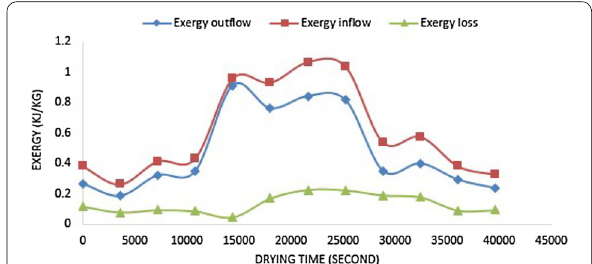
Fig. 12 Exergy as a function drying time (3rd day) onion